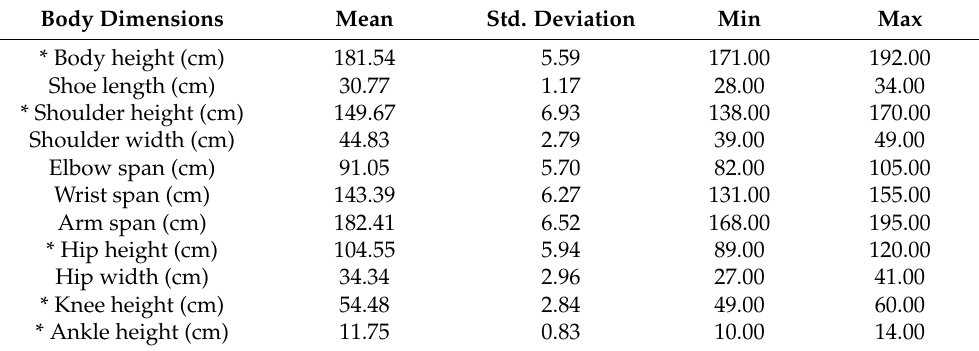
Table 1. Anthropometric parameters from the chainsaw workers participating in the study (n = 28). Body